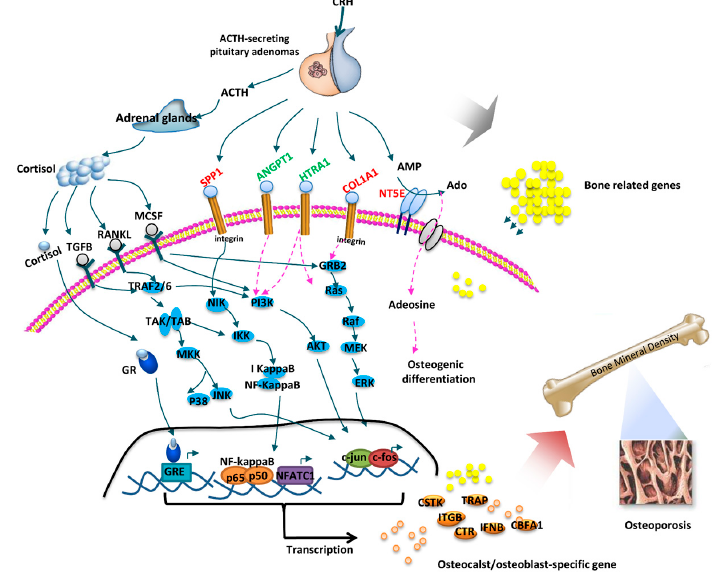
Figure 5. Potential molecular mechanisms of osteoporosis in ACTH-secreting pituitary adenomas.